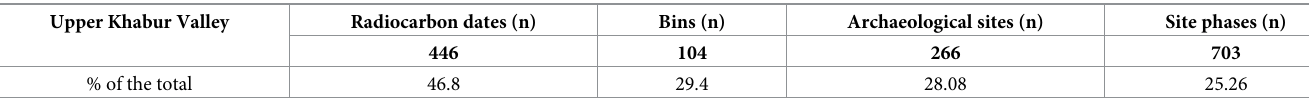
Table 2. Archaeo-demographic proxies in the Upper Khabur